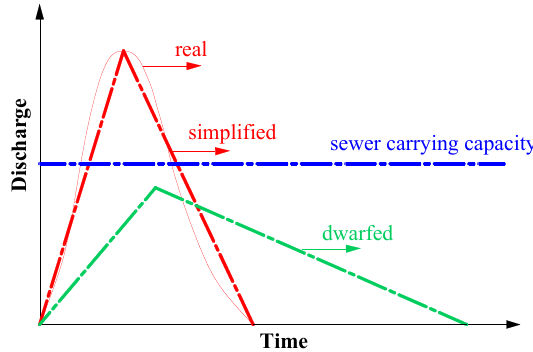
Figure 1. Typical runoff hydrographs and their simplified forms.